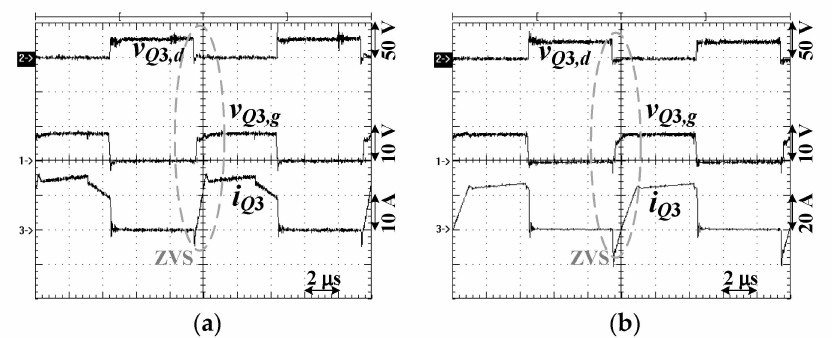
Figure 10. Experimental waveforms of Q 1 at ( a ) V in = 30 V and 20% load, ( b ) V in = 30 V and 100% load, ( c ) V in = 240 V and 20% load, and ( d ) V in = 240 V and 100% load.